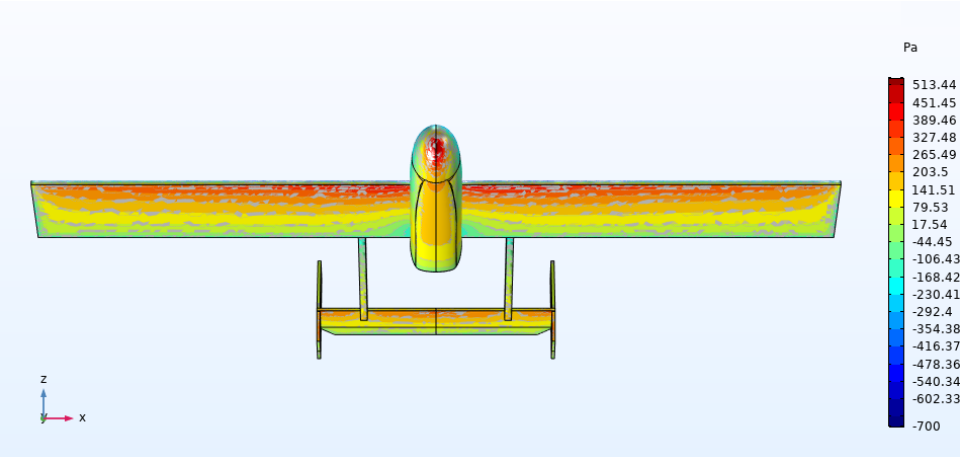
Figure 3. Bottom UAV focused view of maximum pressure in Pa at 2000m of altitude and 30°